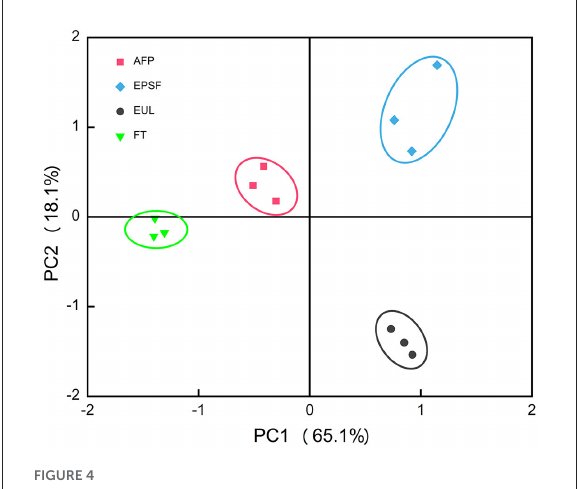
FIGURE4 Principal component analysis of the electronic nose data of bigeye tuna transported via various logistics packaging